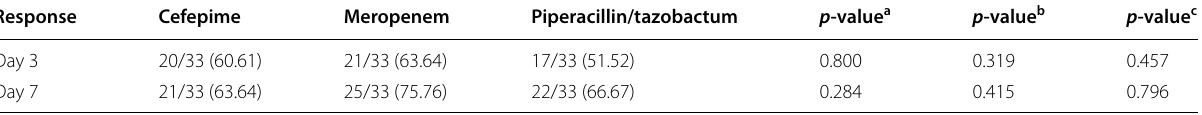
Table 3 Treatment response on days 3 and 7